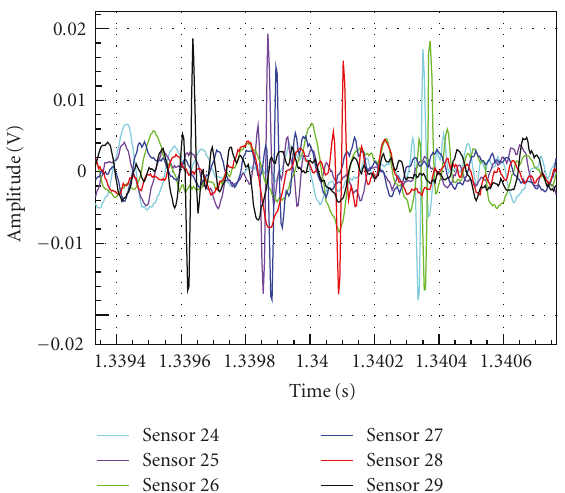
Figure 7: Signals recorded by one local cluster, consisting of six hydrophones.